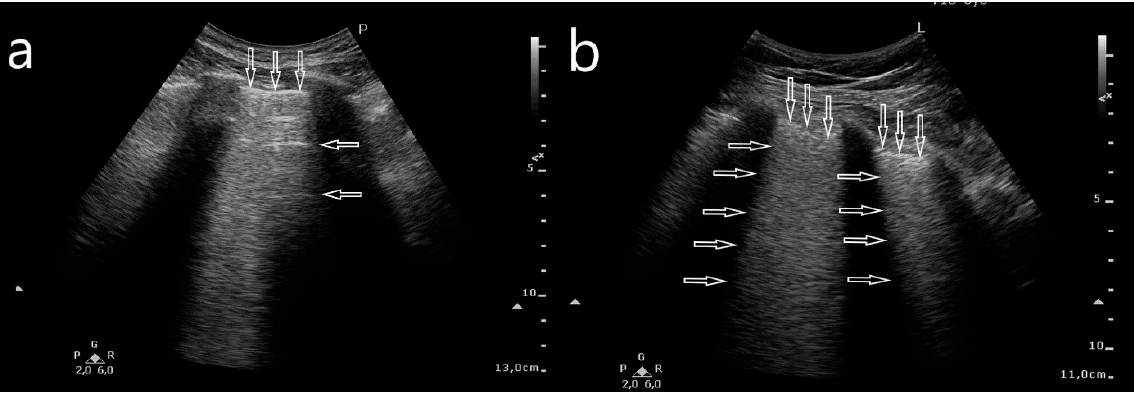
Figure 3. B-line artifacts evaluated with a convex transducer: ( a ) A-line artifacts (horizontal arrows) and pleural line (ver- tical arrow). ( b ) White lung: pleural line (vertical arrow) and confluent B-line artifacts (horizontal arrows).